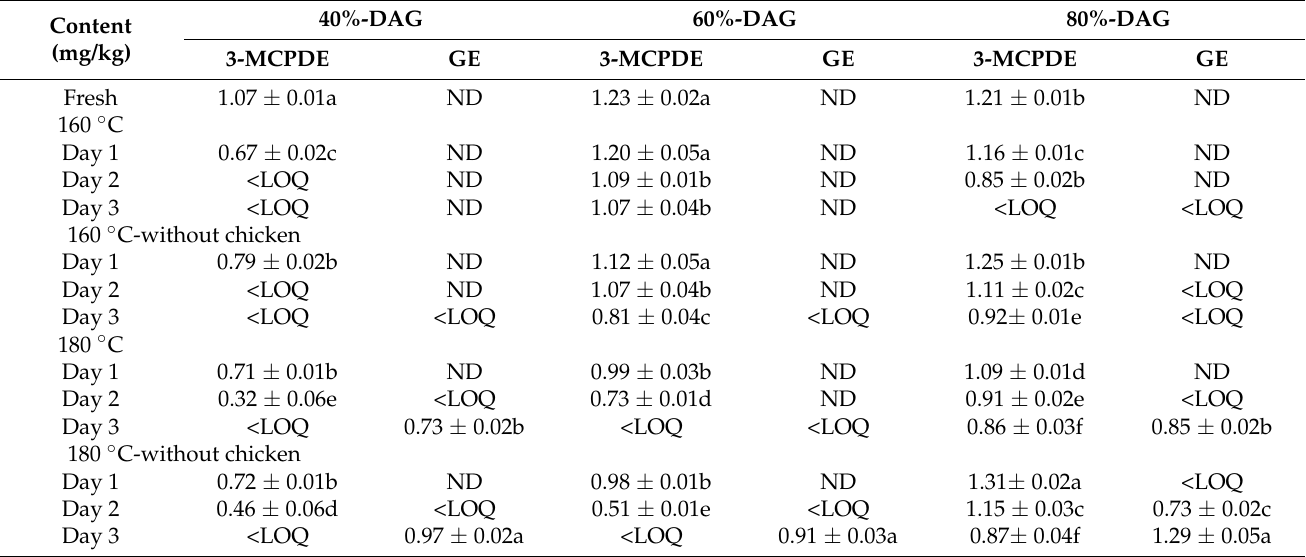
Table 4. The 3-MCPDE and GE of oil after frying for 3